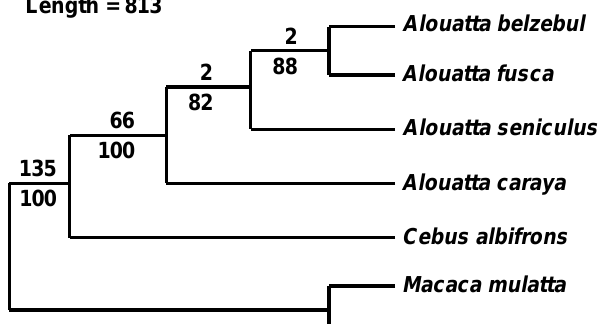
Figure 4 - Maximum parsimony tree derived from the aligned g 1 -globin nucleotide sequences in seven simian species. The length, or nucleotide sub- stitution score, is 813. Values above the lines represent the minimum num- ber of additional substitutions required to break up the clade designated by that node and those below the lines, the percentage of bootstrap values ob- tained in 2,000